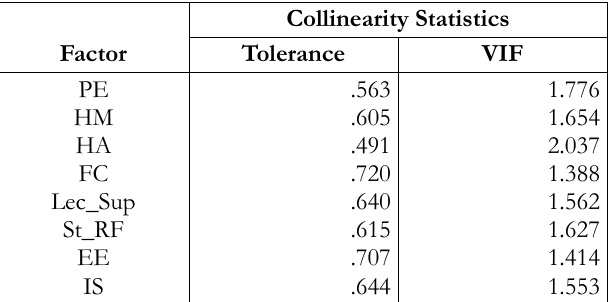
Table 5. VIF and Tolerance Statistics